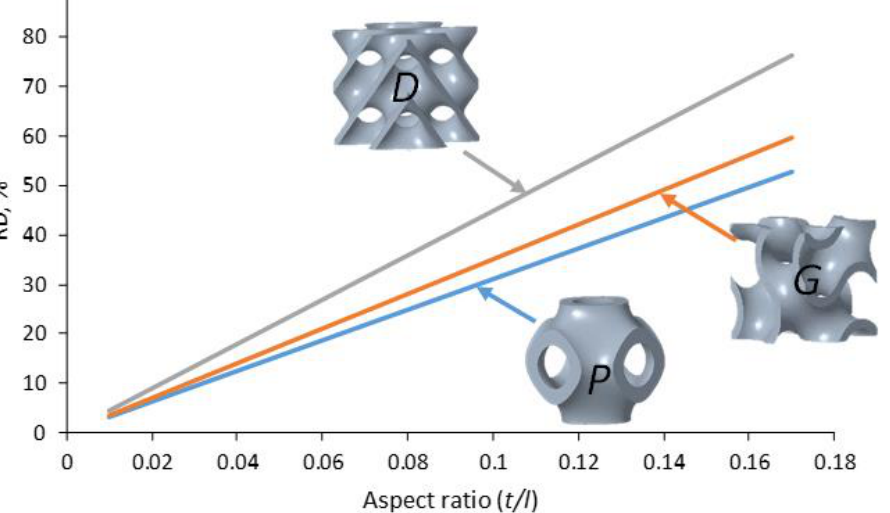
Figure 2. Relative density RD% as a function of t/l ratio of Primitive, Gyroid, and Diamond TPMS unit cells.